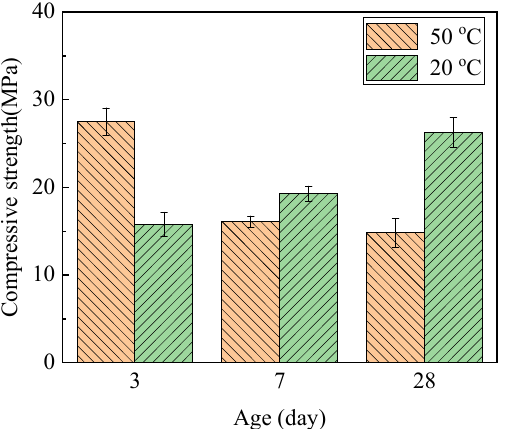
Figure 5. Compressive strength of M-S-H prepared using dead-burned MgO. The shrinkage of mortars prepared using MgO calcined at 1450 °C for 0.5 h and 2 h, cooled in air and the oven, respectively, is depicted in Figure 6. The shrinkage curves can be divided into two stages. An approximate linear growth period was observed before 20 d, and the second stage was a deceleration period. Shrinkage in the linear growth period accounted for 40% of shrinkage in the first 120 d. That the mortar prepared using 14A0.5 had more shrinkage is consistent with the experimental results of Ma [28] This indicates that the formation of MH in M-S-H systems did not cause expansion in the system [29,30]; this differs from the expansion caused by periclase in traditional silicate cement.